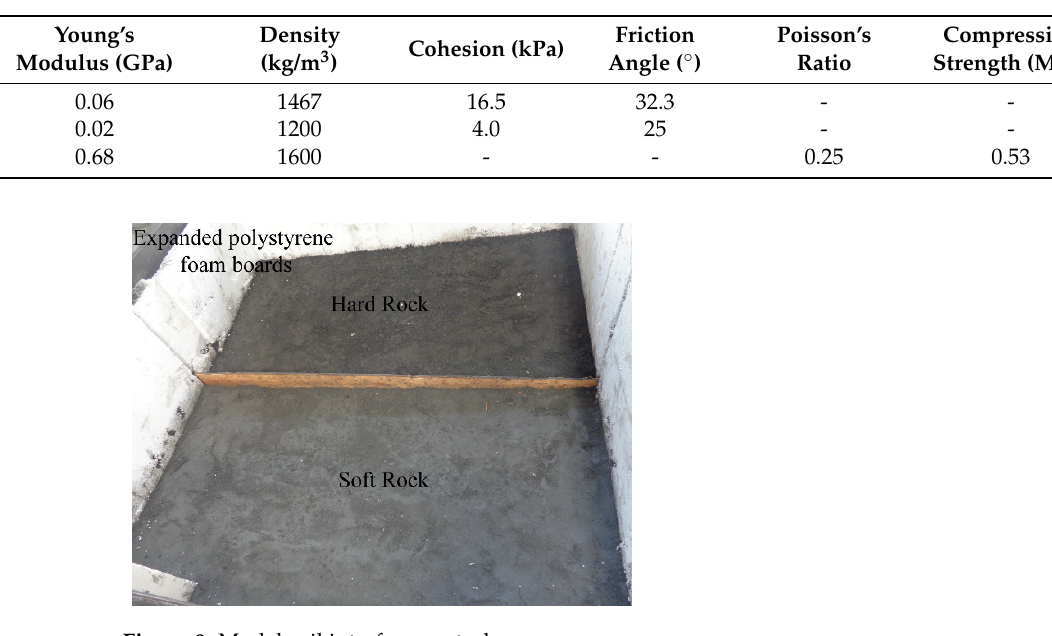
Table 2. Parameters of the model.